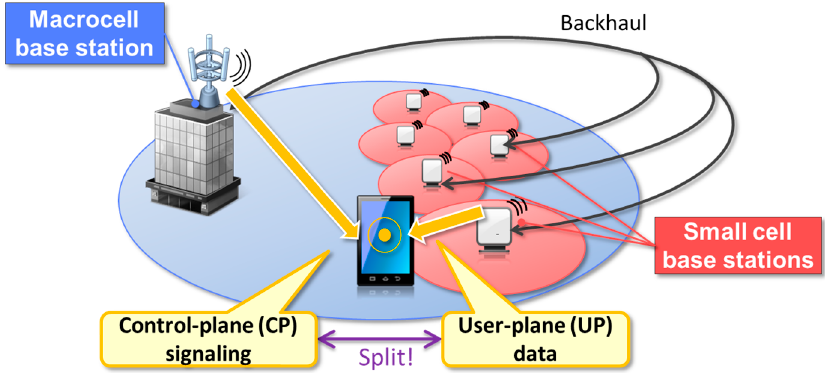
Figure 1. CP/UP splitting in the C-RAN-based HetNet architecture.